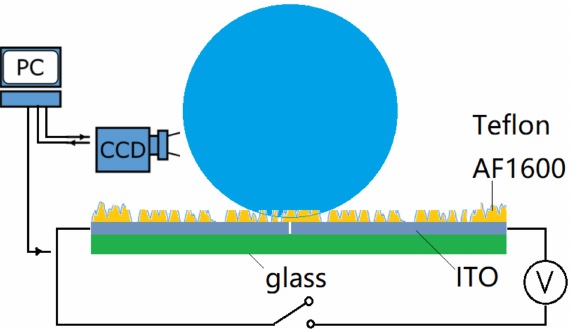
Figure 1. Experimental setup for electrowetting-assisted droplet jumping and trampolining. Note that the Teflon layer has been plasma etched to form superhydrophobic nano structures on